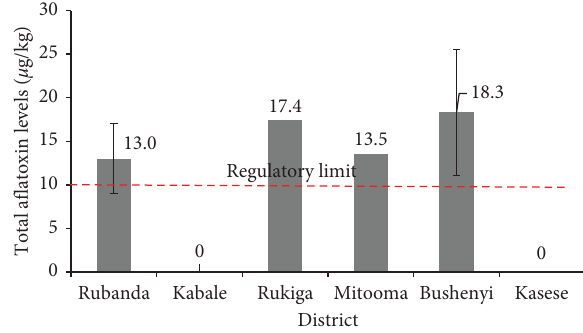
Figure 2: Total afatoxin levels (mean ± SEM) in maize four samples in selected districts of S.W. Uganda (the regulatory limit for E. Africa is in broken lines).